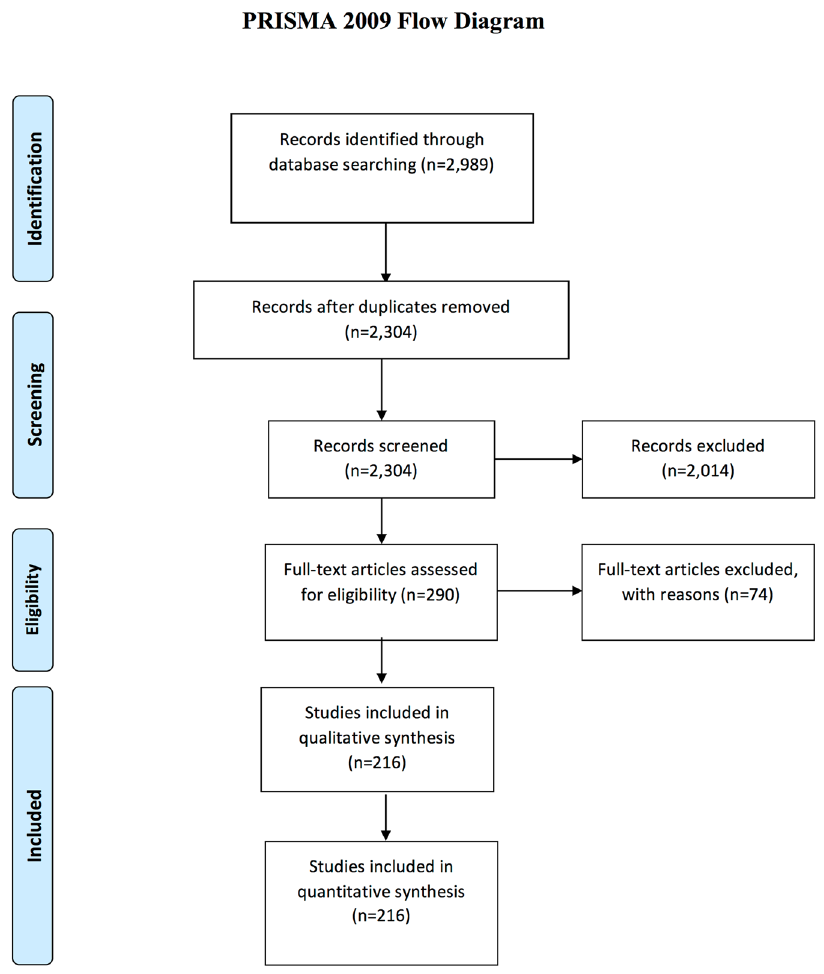
Figure 1. PRISMA Flow